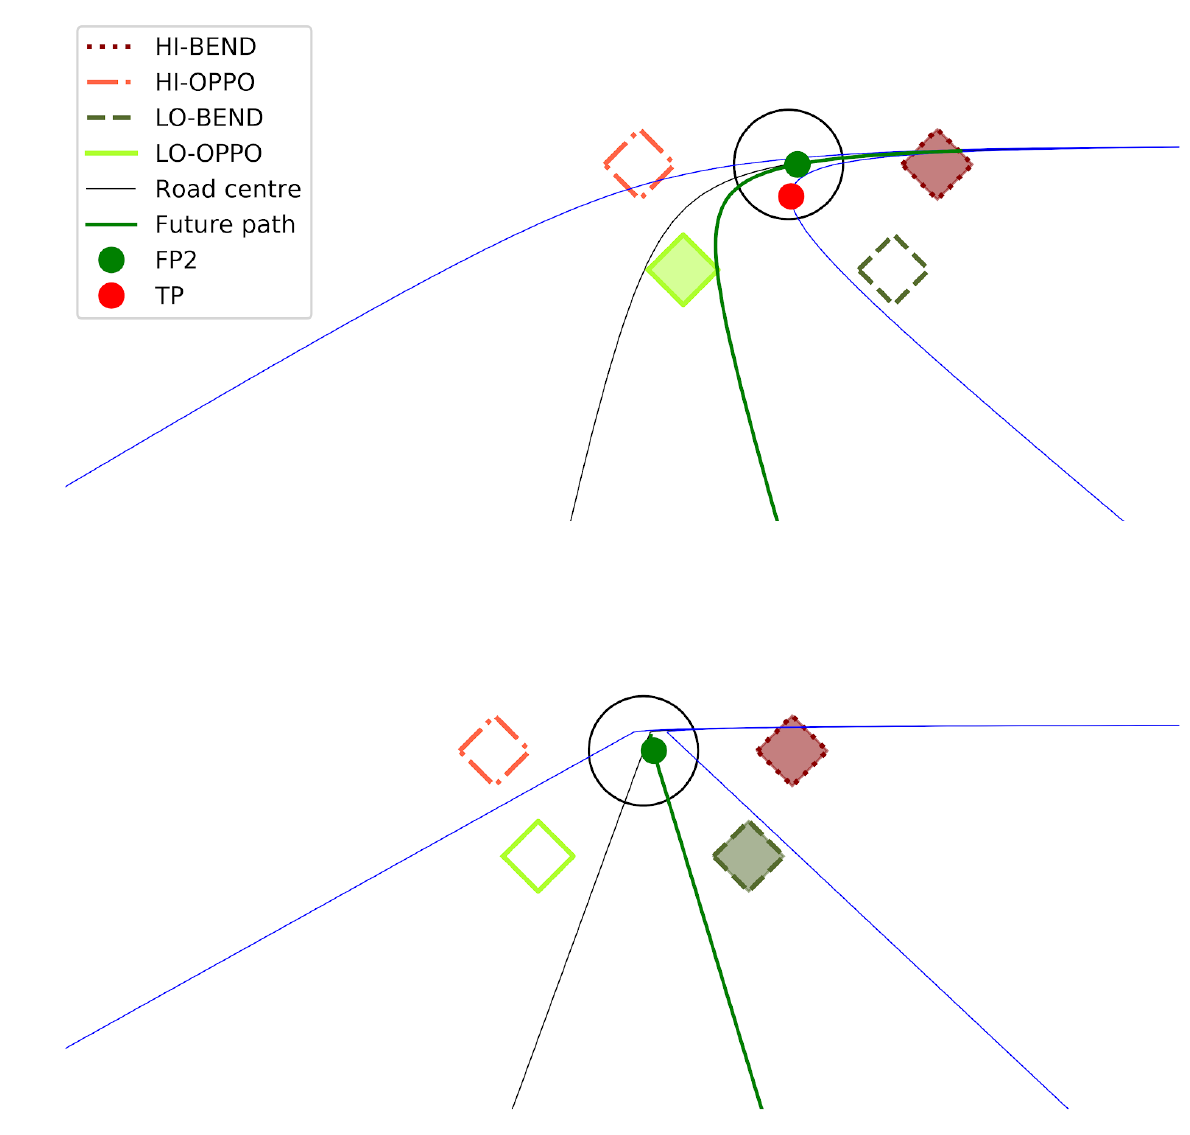
Figure 6 . Target positions in bends (top panel) and on straights (bottom panel). Green dot (FP2) = future path travel point at 2s time headway; Red dot (TP) = Tangent point (bend only). The shaded targets mark the locations where based on prior literature we expected better detection performance. If planned but not executed look-ahead fixations produce a top-down attentional cueing effect, then the detection of targets presented in the HI-BEND location should be facilitated compared to the detection of targets in the HI-OPPO location. If the horizontal optic flow during cor- nering leads to a bottom-up attentional cueing effect, this should be observed in the bends (only). While LO-BEND falls closer to the road edge than LO-OPPO, in bends it typically falls outside the road whereas LO-OPPO is situated close to the future-path. If attention is spread evenly along the future path, then both the HI-BEND and (in corners) LO-OPPO target detection should be